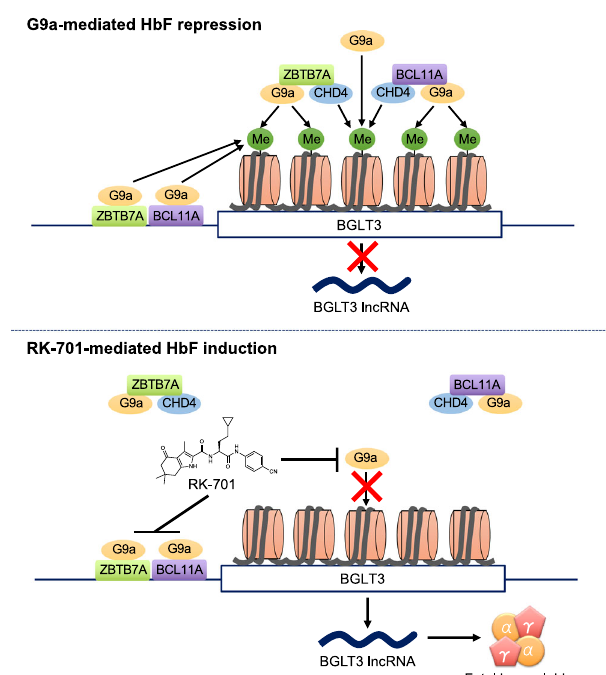
Fig.8|AschematicmodelofthemolecularmechanismbywhichG9arepresses fetal globin gene expression. Two major HbF repressors, BCL11A and ZBTB7A, recruit G9a onto the BGLT3 gene locus, where G9a facilities H3K9me2. G9a- mediated H3K9me2 recruits BCL11A and ZBTB7A onto the BGLT3 gene locus via CHD4,which may further enhance locus-speci fi c H3K9me2. Thispositive feedback loop of enhancement of H3K9me2 at the BGLT3 gene locus ensures to repress BGLT3 lncRNA and subsequent fetal globin expression. RK-701 reactivates fetal globin by disrupting this G9a – BCL11A/ZBTB7A system by inhibiting the enzymatic activity of